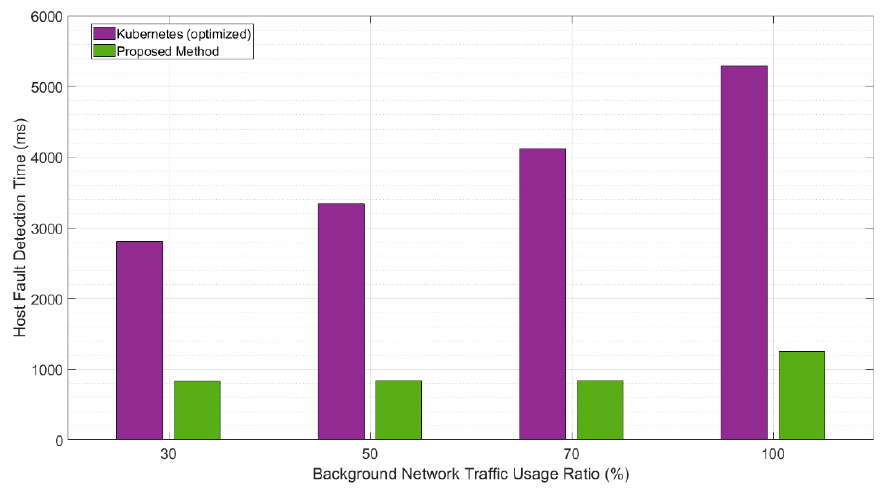
Figure 7. Comparison of fault-detection times with background network traffic.